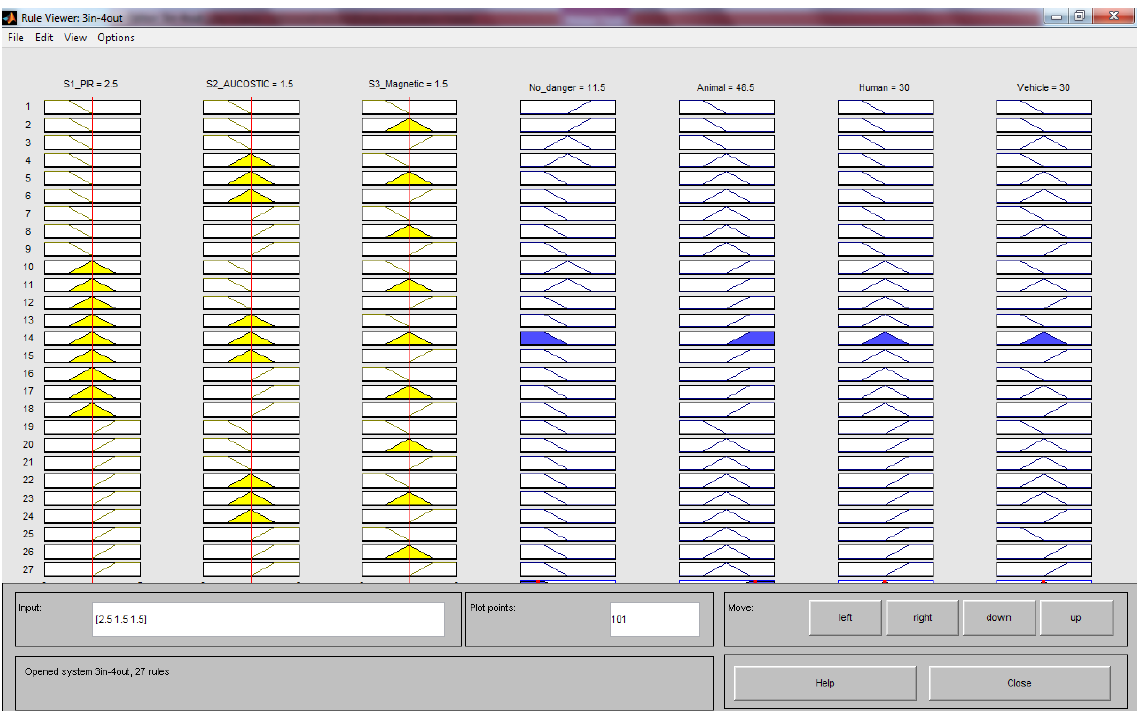
Figure 10. Theinputs and the corresponding outputs